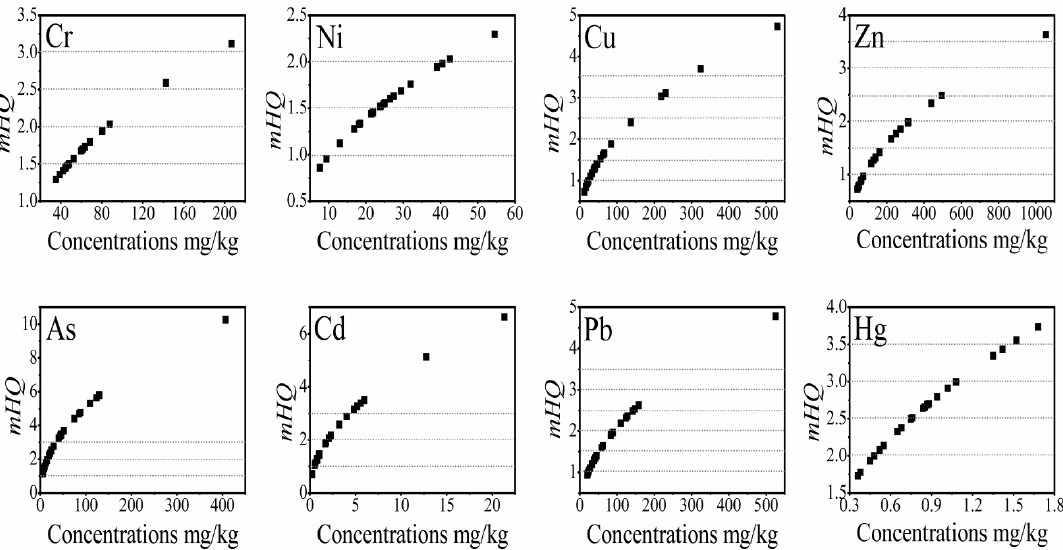
Figure 8. The mHQ values of Cr, Ni, Cu, Zn, As, Cd, Pb, and Hg in sediments based on SQG values (TEL, PEL, SEL) and total heavy metal concentrations.